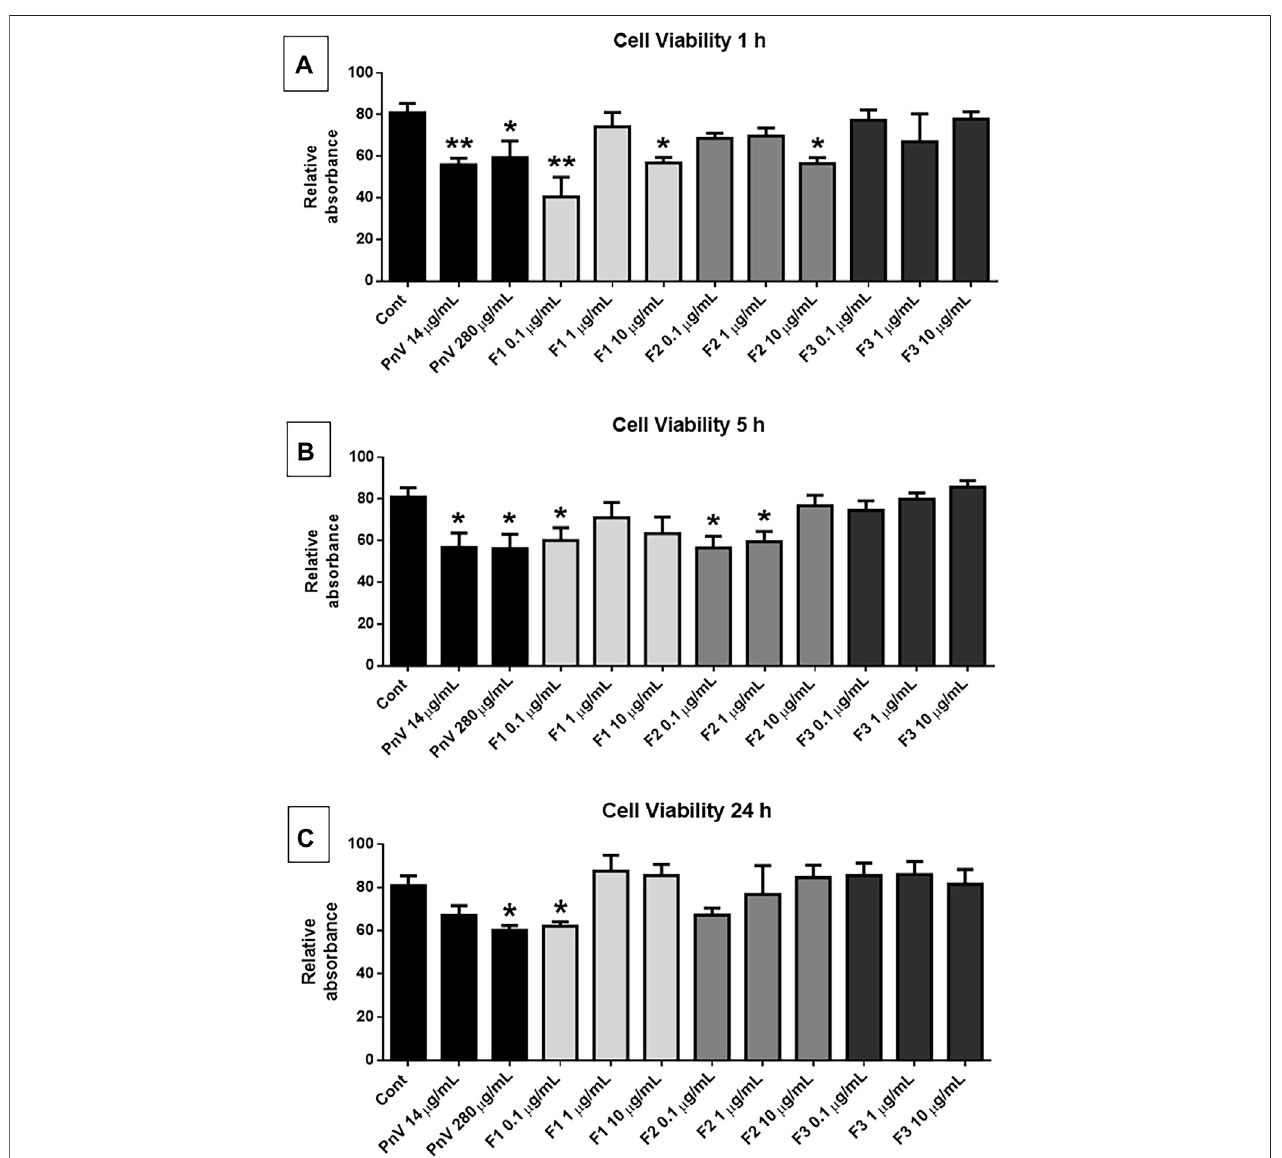
FIGURE 2 | Cell viability assay (MTT): human GB cells treated with F1, F2, and F3 (0.1, 1, and 10 μ g/ml). (A) After 1 h of treatment, F1 0.1 μ g/ml was the most effective in reducing the viability of GB cells, compared to untreated control; F1 and F2 at 10 μ g/ml were also signi fi cant. (B) After 5 h of treatment, F2 (0.1 μ g/ml) signi fi cantlyreducedtheviabilityofGBcells. (C) After24 hofexposure,nosigni fi canteffectwasobserved.One-wayANOVAfollowedbyDunnett ’ smultiplecomparisons test was performed; unpaired Student ’ s t-tests were used to compare each treatment with the control. * p < 0.05, ** p < 0.01, **** p < 0.0001, compared to the control